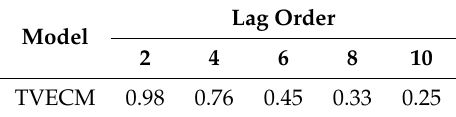
Figure 3. Historical process of deviation z t . Table 6. p -values of Ljung–Box autocorrelation test for TVECM.